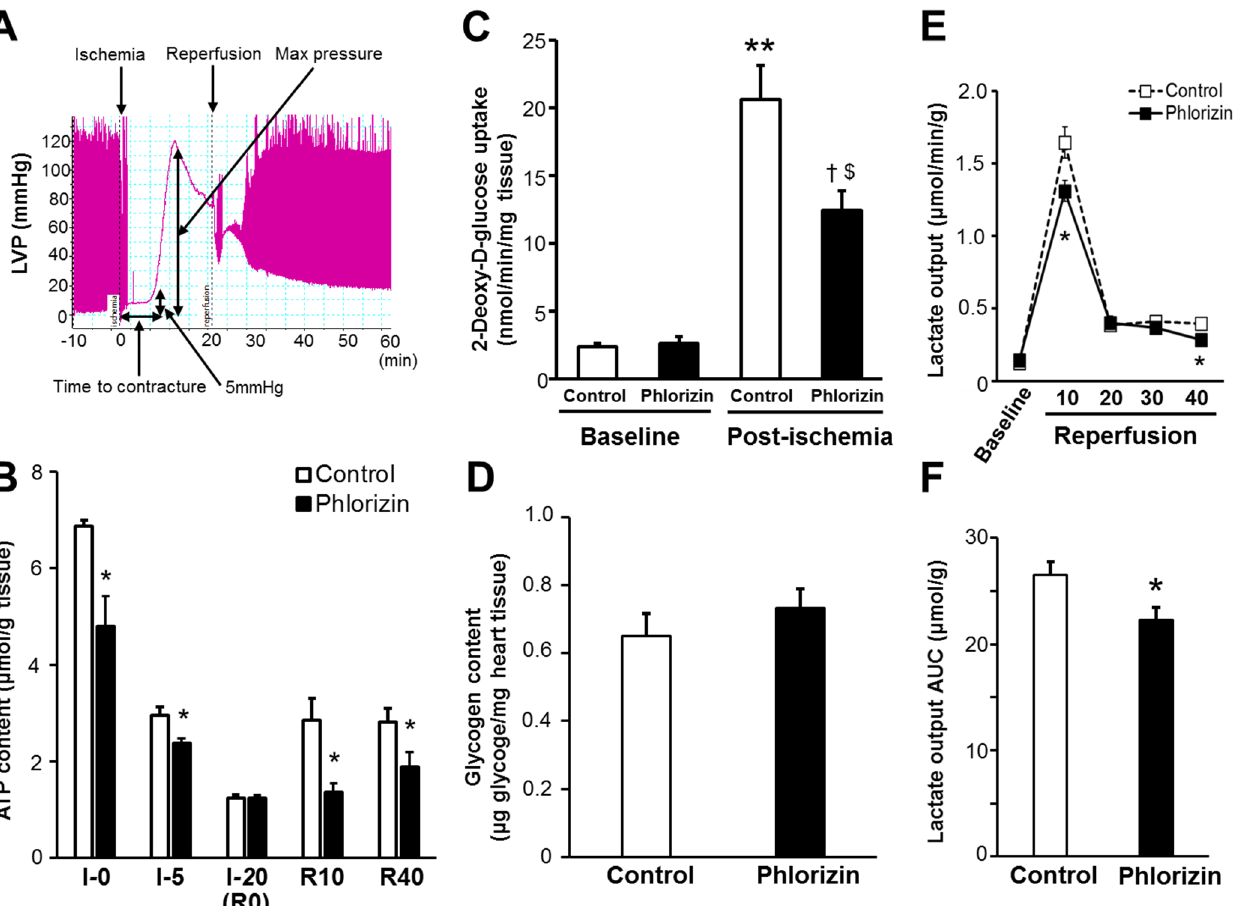
Fig 6. Phlorizin reduced tissue ATP content in the heart, associated with decreased glucose uptake and glycolytic flux during IRI. (A) Ischemic contracture was observed as a sigmoid increase in end-diastolic pressure, the onset and extent of which was recorded. The definitions of the individual parameters are shown. (B) The tissue ATP content in the hearts measured at the indicated time points (Ischemia 0 minutes: n = 4 each, Ischemia 5 minutes: n = 4 each, Ischemia 20 minutes: phlorizin-perfused; n = 4, control; n = 7, Reperfusion 10 minutes: phlorizin-perfused; n = 7, control; n = 8, Reperfusion 40 minutes: phlorizin-perfused; n = 7, control; n = 8). * P < 0.05 versus control. (C) Glucose uptake in the hearts perfused with or without phlorizin under the pre- ischemic baseline condition (n = 6 each) and post-ischemic condition measured at 10-minute reperfusion following 20-minute global ischemia (phlorizin- perfused; n = 7, control; n = 6). ** P < 0.01 versus the control hearts at baseline; † P < 0.01 versus the phlorizin-perfused hearts at baseline; $ P < 0.05 versus the control hearts at post-ischemia. (D) Glycogen content in the perfused hearts under the baseline condition prior to global ischemia (n = 4 each). (E) Lactate output profiles in the effluent collected during the reperfusion period (n = 10 each). * P < 0.05 versus control. (F) AUC was calculated from the lactate output profiles shown in (E) (n = 10 each). * P < 0.05 versus control.